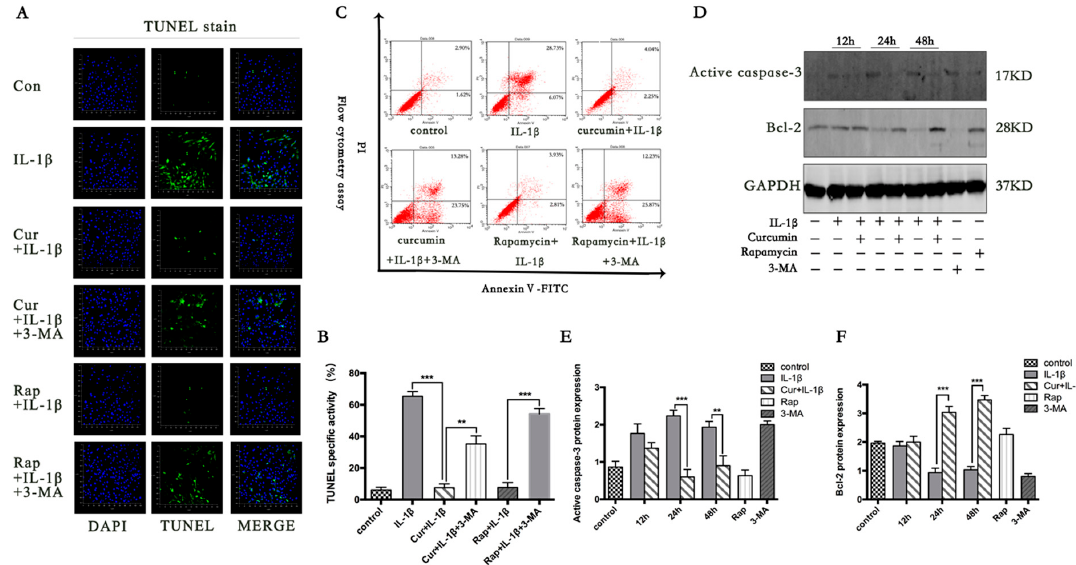
Figure 3. Effects of curcumin on IL-1 β -induced apoptosis in primary chondrocytes. ( A ) Apoptotic cells were visualized using terminal deoxynucleotidyl transferase mediated dUTP nick end labeling (TUNEL) fluorescence immunocytochemistry (green). Nuclei were counterstained with 4 ′ ,6-diamidino-2-phenylindole (DAPI) (blue); ( C ) Flow cytometric detection of apoptosis in the chondrocytes. Apoptotic cells labeled with Annexin V and propidium iodide (PI) fluorescence were estimated by flow cytometry. The percentages of cells in each quadrant is indicative of: upper left, necrotic cells; lower left, live cells; lower right, early apoptotic cells; and upper right, late apoptotic cells; ( D ) Accumulation of cleaved caspase 3 and bcl-2 was visualized by western blot. Results shown in ( B , E , F ) are expressed as means ± SD for experiments performed in triplicate. * p < 0.05, ** p < 0.01, and *** p < 0.001.Con, control; Rap, rapamycin; Cur, curcumin; 3-MA, 3-Methyladenine.